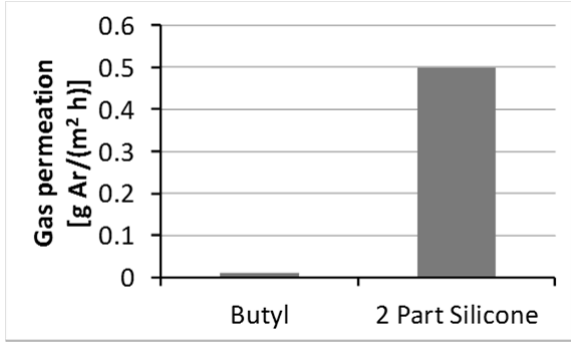
Fig. 3 Argon permeation of butyl vs. 2 part silicone